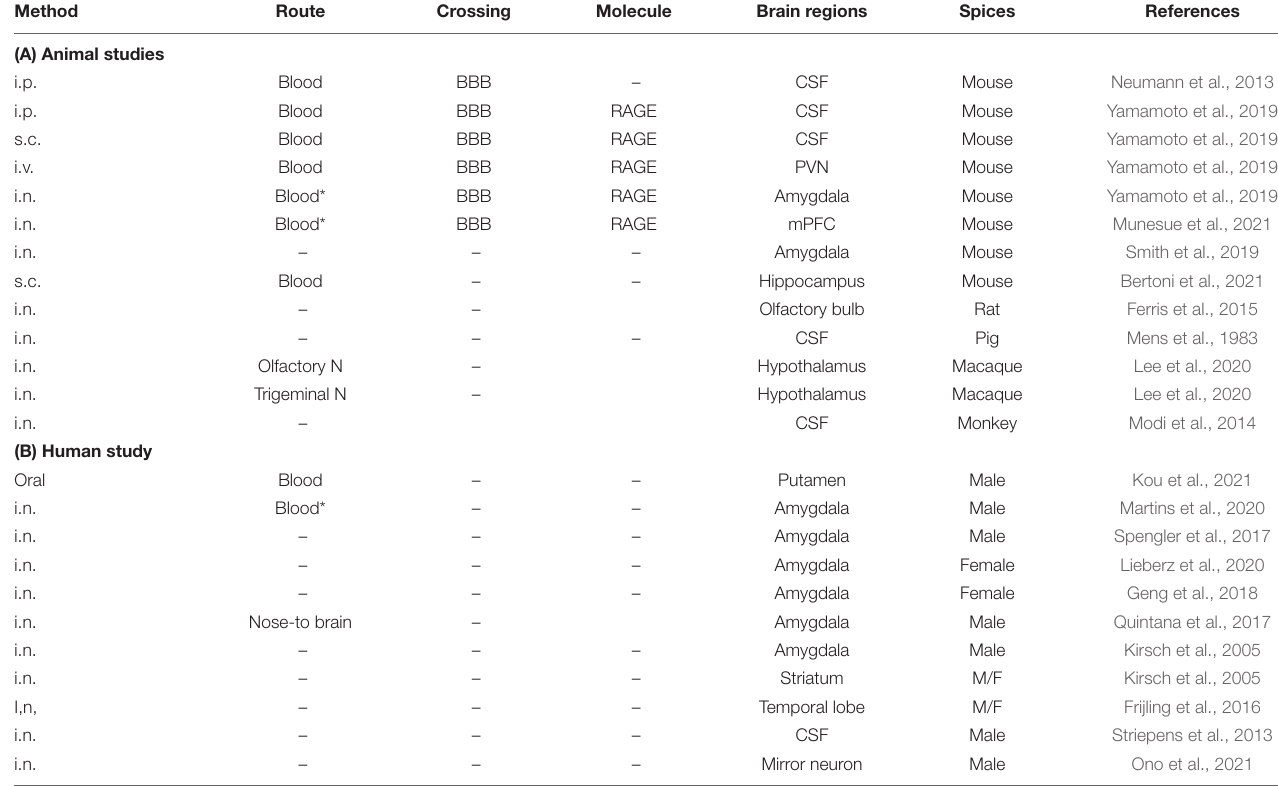
TABLE 2 | Identified transport molecules and routes of oxytocin to the brain after peripheral administration.